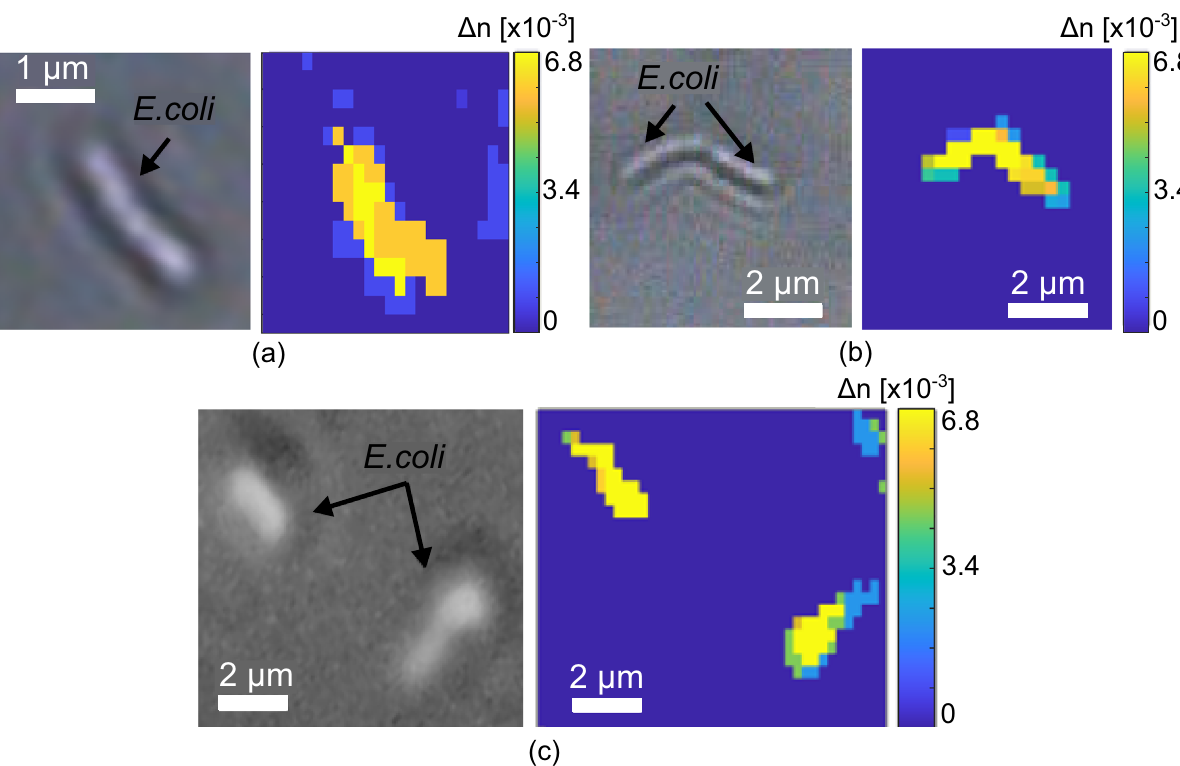
Fig. 5 Imaging of individual E. coli bacteria. a – c Microscope images (left) and hyperspectral imaging (right) of individual E. coli